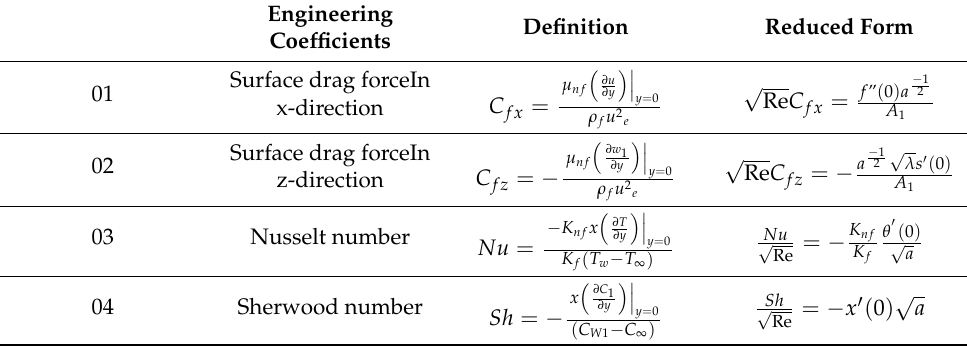
Table 3. Engineering coefficients and its reduced